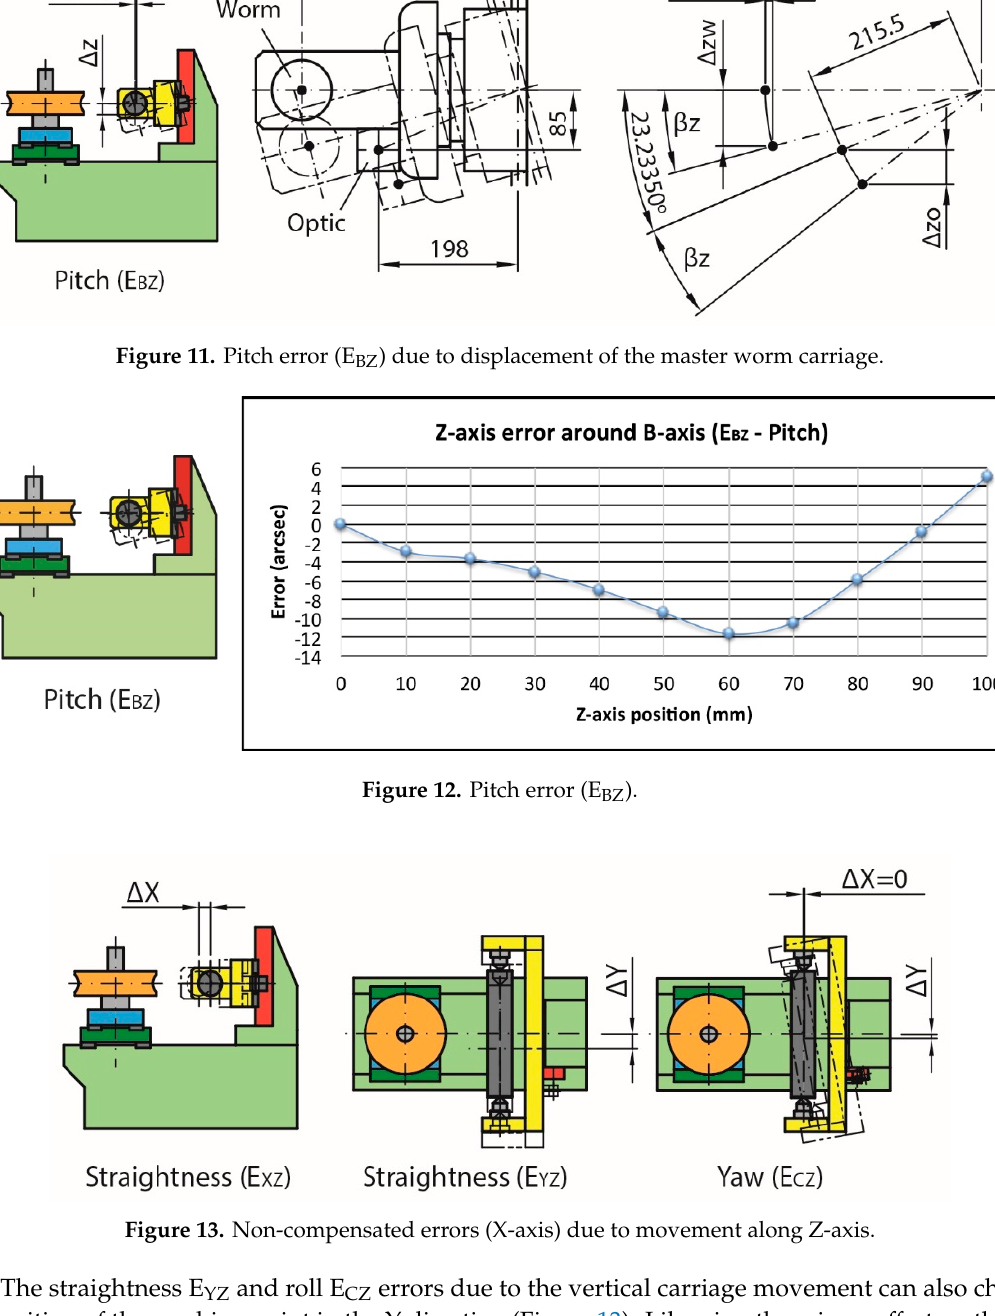
Figure 13. Non-compensated errors (X-axis) due to movement along Z-axis.